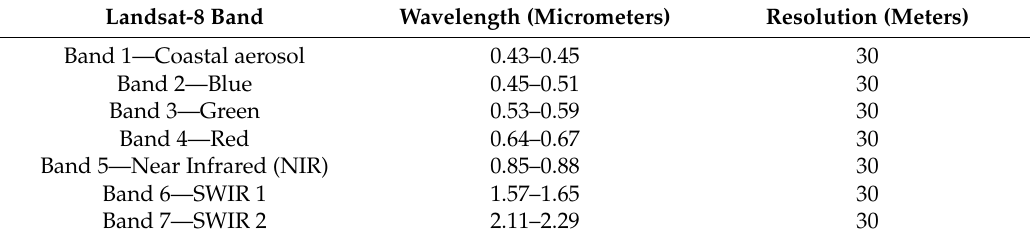
Table 2. Name of the Landsat-8 bands, their wavelength and resolution that we included in the RF